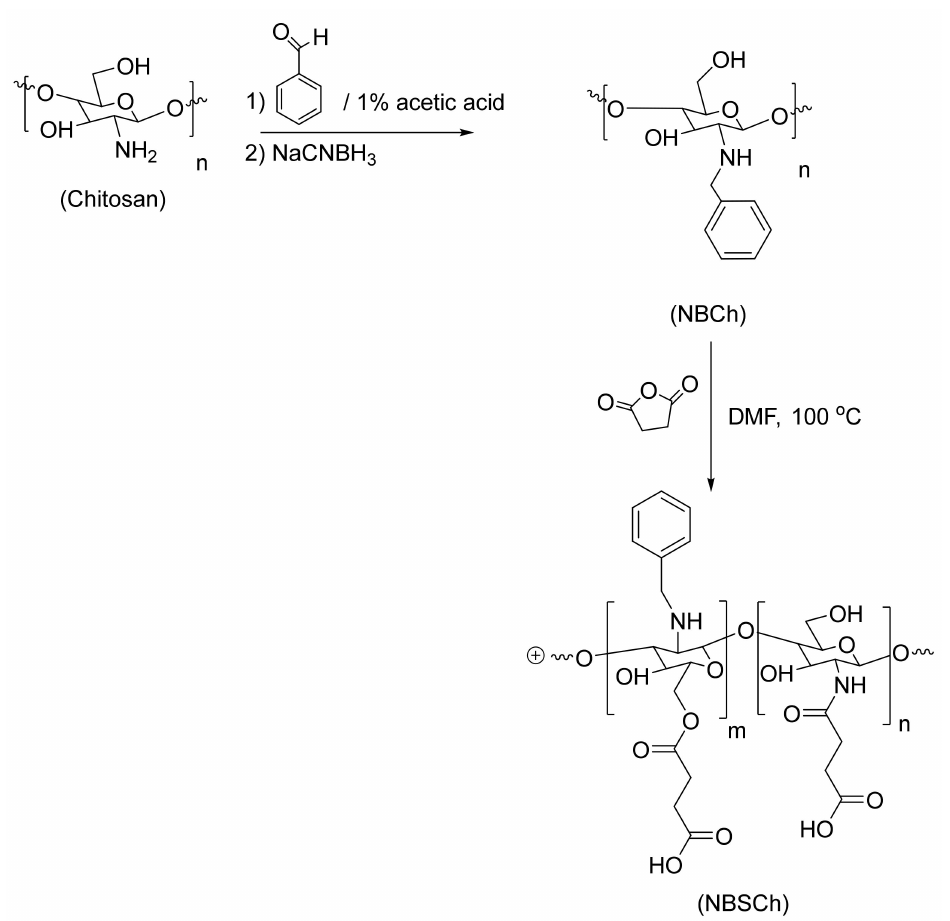
Figure 12. Synthesis scheme for N -benzyl- N , O -succinyl chitosan (NBSCh). N -benzyl- N , O -succinyl chitosan (NBSCh) was then synthesized by succinoylation as described. Briefly, N -benzyl chitosan NBCh (5 g) was dispersed in 450 mL dimethylfor- mamide (DMF) 450 mL, and succinic anhydride (15 g, 0.30 mol) was added. The reaction mixture was stirred under nitrogen purge for 24 h, resulting in a clear yellow solution. Excess of succinic anhydride and DMF were eliminated by dialysis against distilled water for 3 days. The final solution in the dialysis bag was freeze-dried to give a yellow powder prior to characterization by FT-IR and 1